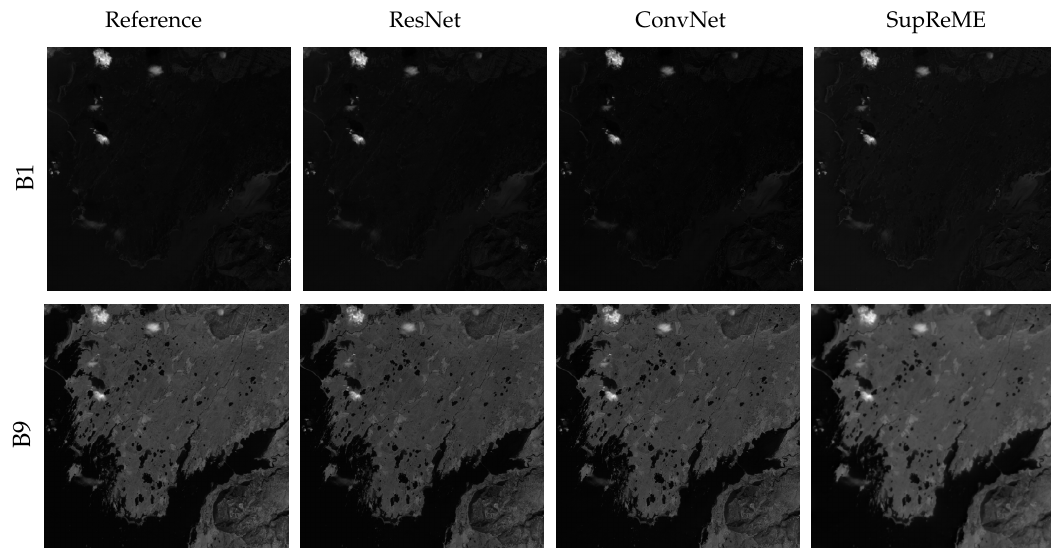
Figure 14. Visual comparison of all methods for bands B1 and B9, which have been fused at the reduced resolution of 360 m to obtain 60 m resolution